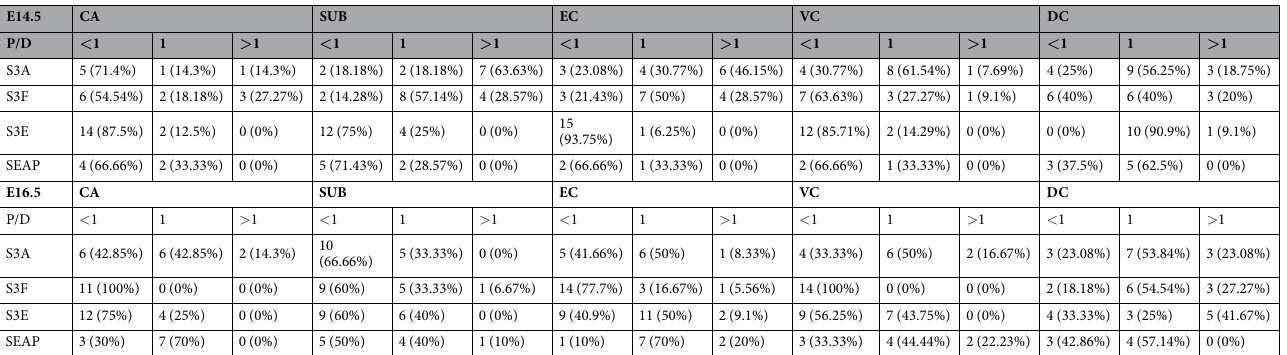
(P/D > 1) responses (see 46 and Supplementary Fig. 2a for details). Results indicated that Sema3E was able to induce chemorepulsion of CA1-3 (E14.5; ≈ 87.5%; P/D ratio < 1; n = 16), subiculum (E14.5; P/D ratio < 1; ≈ 75%; n = 16), entorhinal cortex (E14.5; P/D ratio < 1; ≈ 93.75%; n = 16), and ventrolateral (E14.5; P/D ratio < 1; ≈ 85.71%; n = 14) but not dorsal (parietal) neocortex axons at E14.5. (E14.5; ≈ 90.9%; P/D ratio = 1; n = 11). At later embryonic stages (E16.5) these chemorepulsive actions were largely maintained ((CA1-3; ≈ 75%; P/D